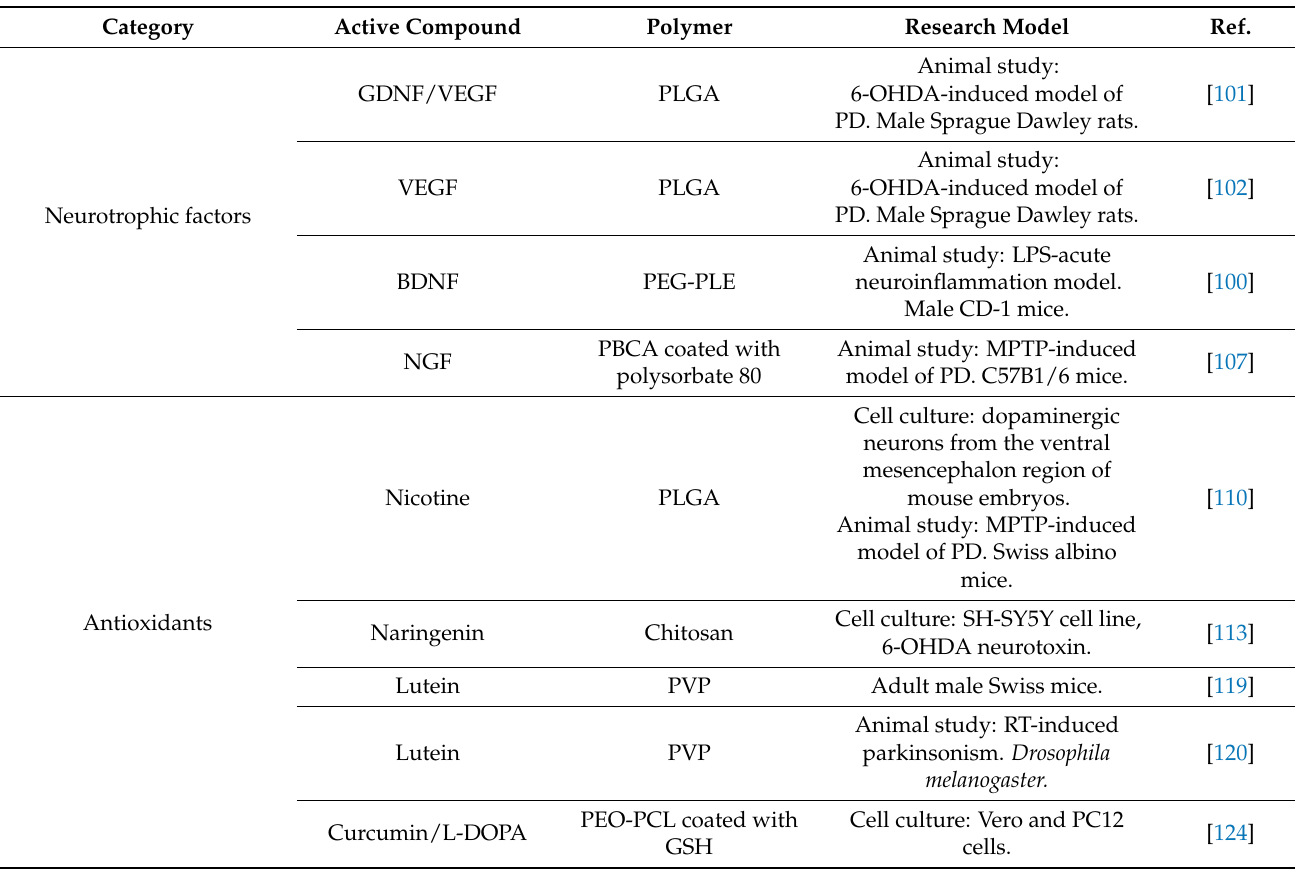
Table 2. Polymeric nanoparticulate systems under investigation for the treatment of